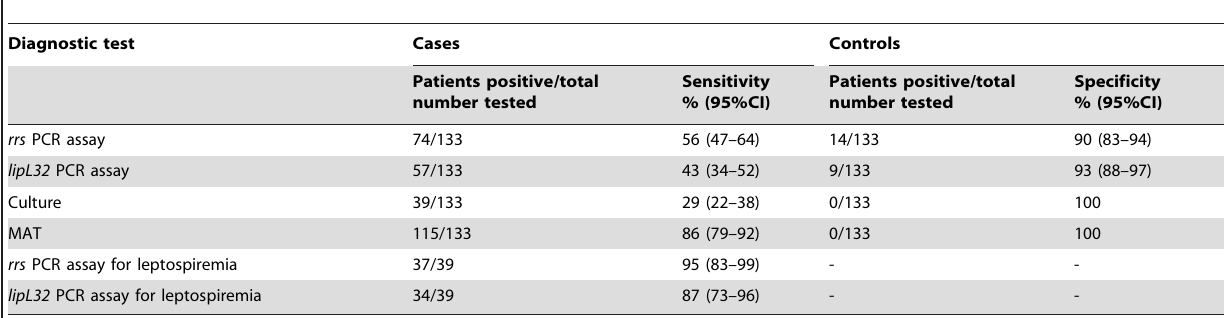
Table 2. Diagnostic sensitivity and specificity of real-time PCR assays targeting rrs or